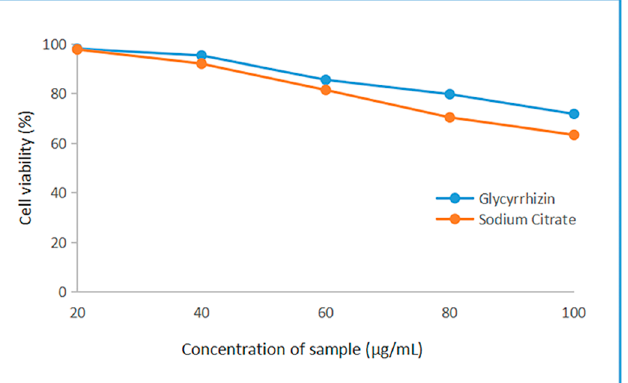
Figure 8. Cell viability of HEK293 cells in different concentrations of glycyrrhizin-reduced AgNPs and sodium citrate-reduced AgNPs.